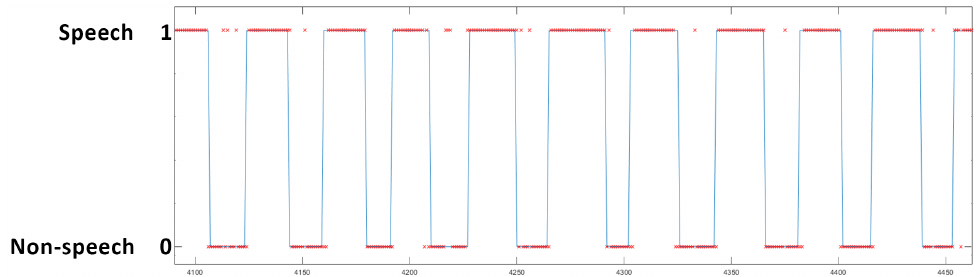
Figure 3. Graphical representation of speech labels (a blue shape) compared with predicted labels (a red crosses) within the range 0 to